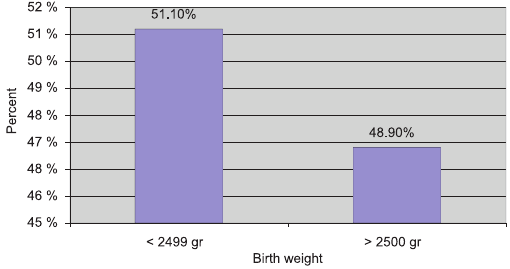
FIGURE 1. Newborn infants with low birth weight in the ex- perimental